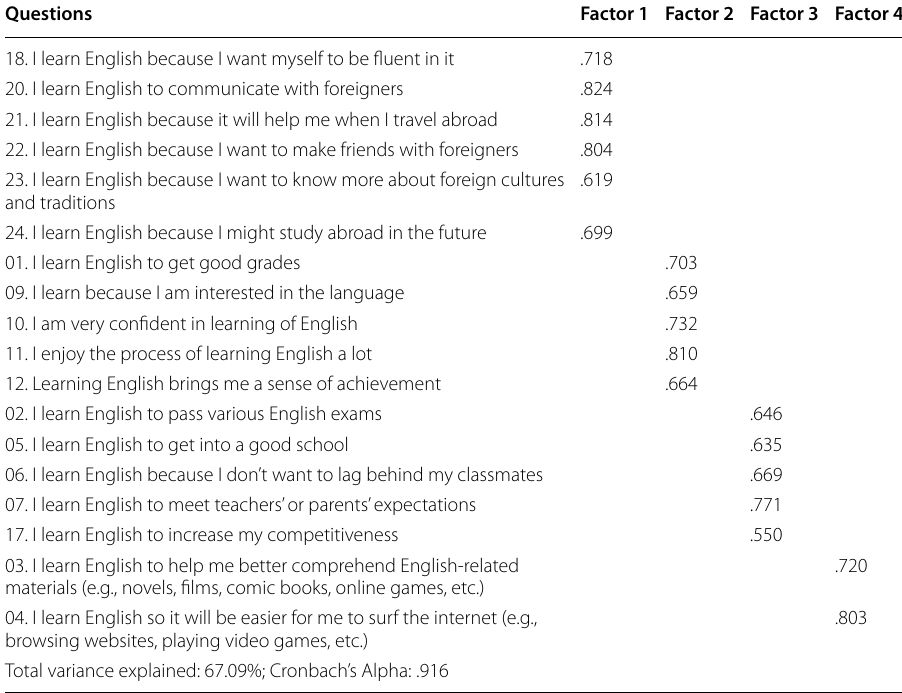
Table 3 Factor loading for teenage EFL learners’ L2 motivation (N